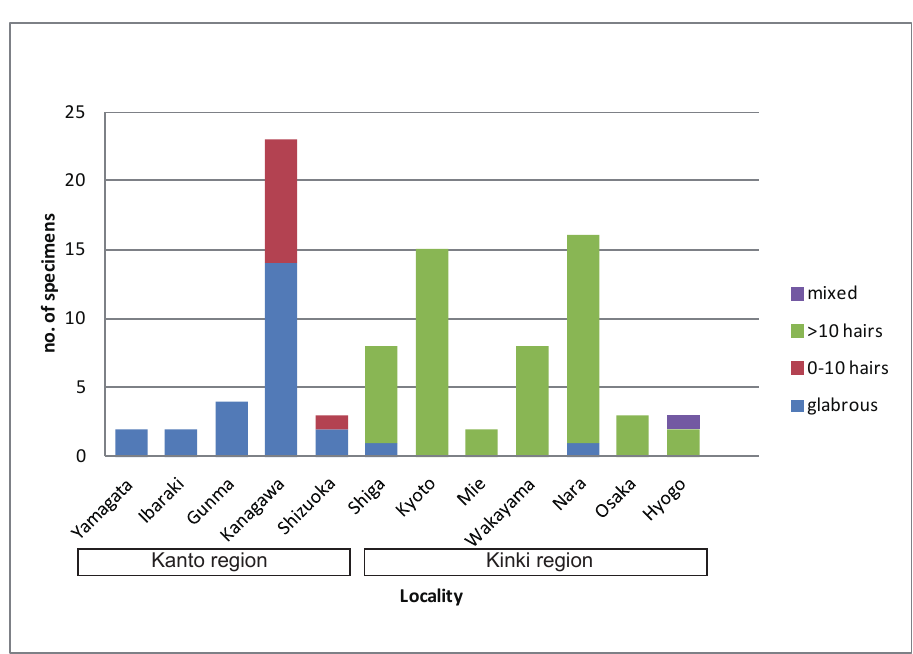
Figure 3. A graph shows the number of specimens examined indumentums at the base of anther